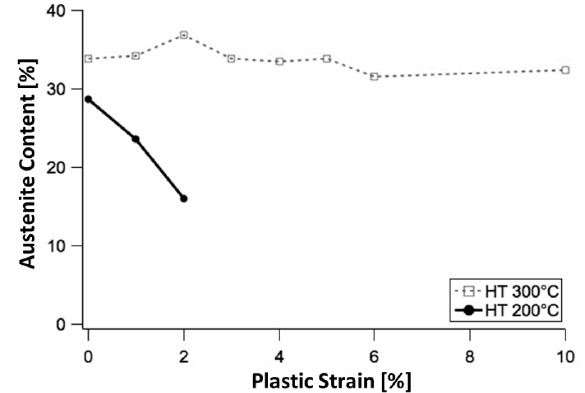
Figure 11. Evolution of austenite content, measured by neutron diffraction, as a function of the plastic strain during a tensile test, for two nanobainitic structures from the same steel after customized isothermal treatments at 200 and 300 °C. Adapted from reference [69].